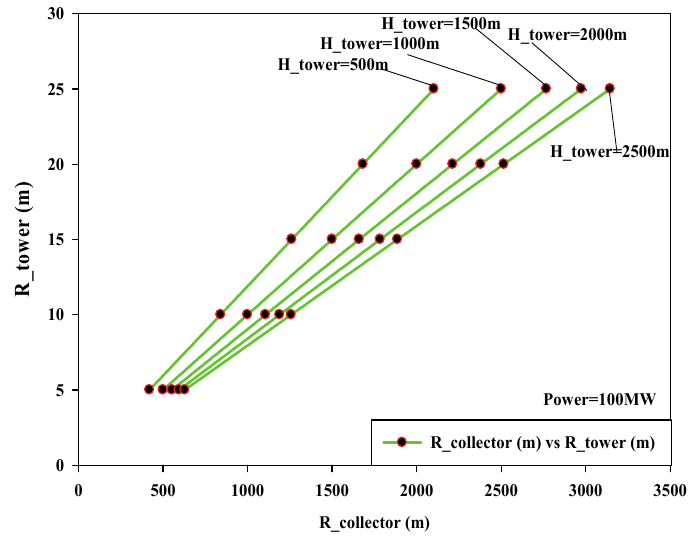
Figure 10. Effect of variation in collector radius ( R Collector ) and tower radius ( R Tower ) at different tower heights ( H Tower ) at 100 MW SUTPP power output.